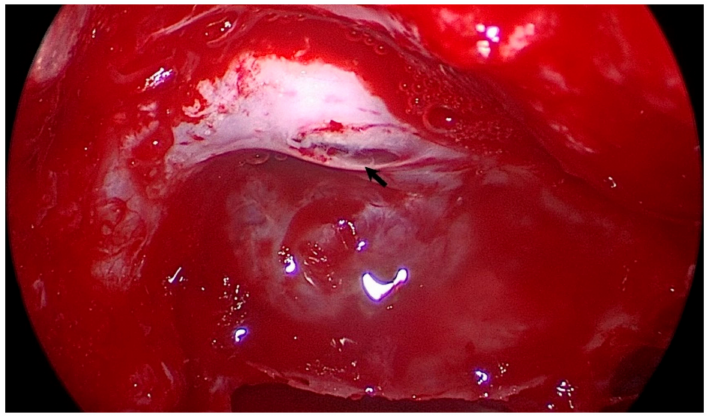
Figure 1. Intraoperative demonstration of right optic nerve following bony decompression and opening nerve sheath (black arrow).